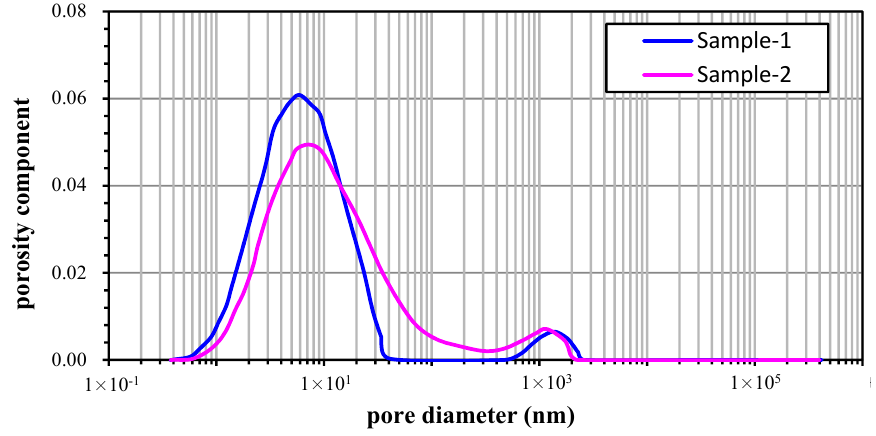
Figure 3. Gas storage and flow mechanisms in shale gas reservoirs.